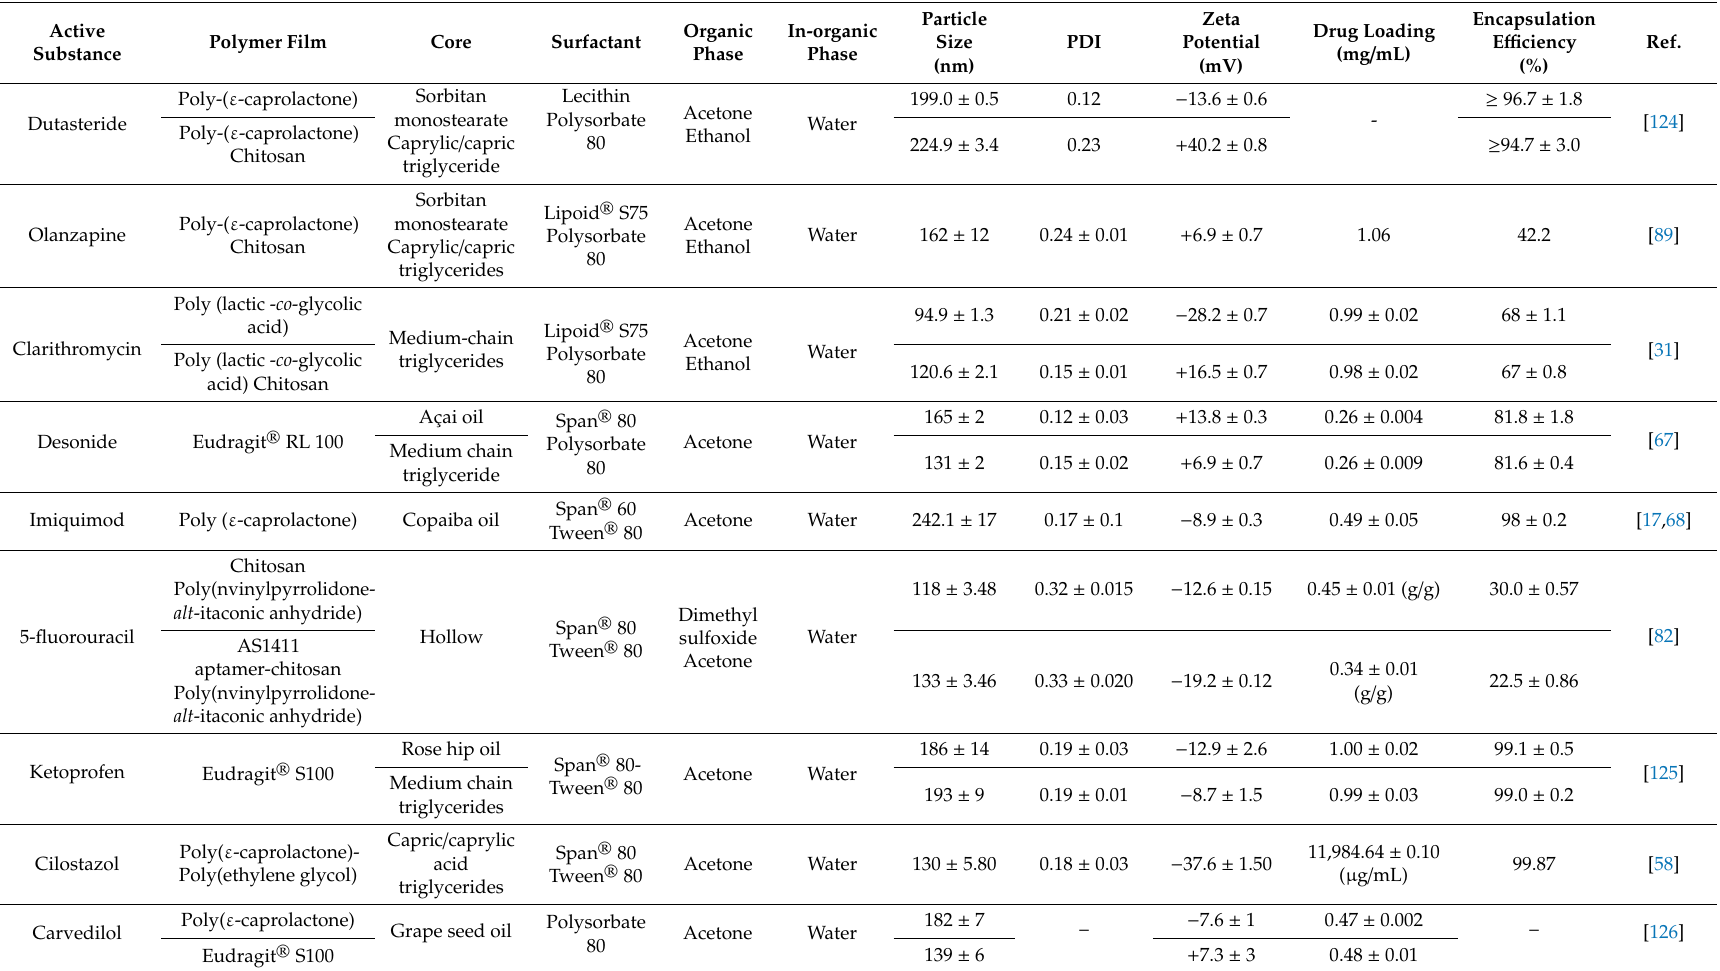
Table 1. Examples of polymeric nanocapsule formulation by interfacial deposition method in recent five